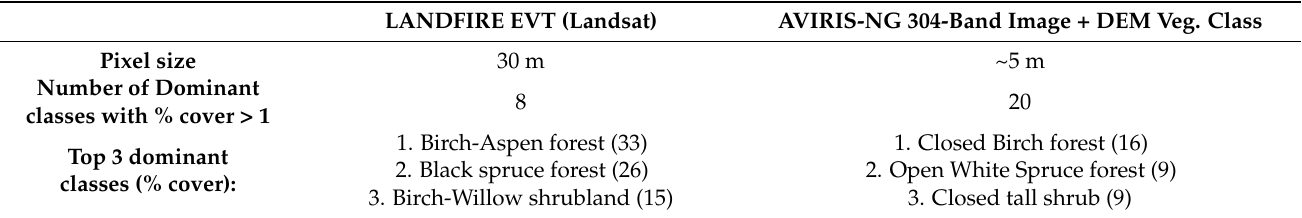
Table 2. Comparison of vegetation map products for LF EVT and AVIRIS-NG 304 band image pixel size, number of dominant vegetation classes, and top 3 dominant vegetation classes by percent cover.